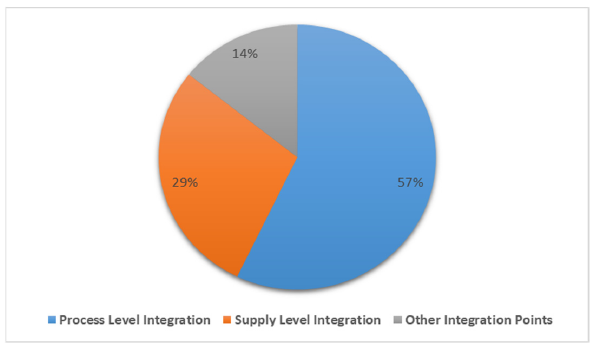
Figure 14. Integration scenario in the mining industry [25,71].